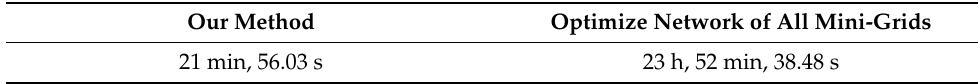
Table 4. Computation times needed to apply our method and calculate the network